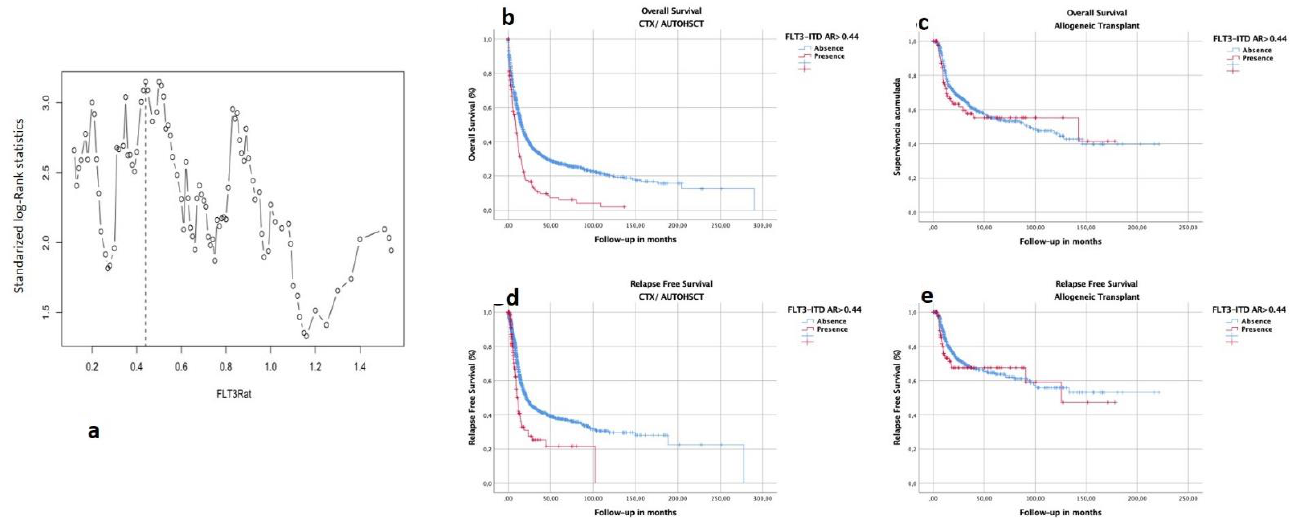
Figure 3. FLT3–ITD AR cutoff point with prognostic impact. Cutoff point selection using maximal log-rank statistics. Optimal cutoff point for AR by maximally selected log-rank statistics in intensively treated FLT–ITD-positive AML cases. Maximally selected log-rank statistics performed for the continuum of AR to test for a potential cutoff point by separating 2 groups with different survival distributions. AR is shown on the x -axis, and the corresponding standardized log-rank statistic is shown on the y -axis. The estimated cutoff point was 0.44, with an M statistic of 3.14 ( a ). The vertical dashed line represents the optimal cutoff point for AR evident on maximally selected log-rank statistics and corresponding M statistics. Impact on prognosis of cutoff point on OS for patients with AML consolidated with CTX/auto-HSCT ( b ) or with allo-HSCT ( c ). Impact on prognosis of cutoff point on RFS for patients with AML consolidated with CTX/auto-HSCT ( d ) or with allo-HSCT ( e ). In the groups consolidated with CTX/auto-HSCT, the estimated median OS in group with FLT3 –